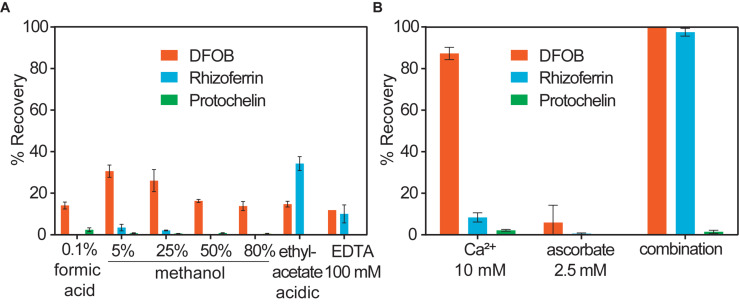
Soil siderophore spike-recovery for DFOB, rhizoferrin, and protochelin (each spiked at 6.25 nmol g–1). (A) Solvent extractions show low recoveries, particularly for rhizoferrin and protochelin. (B) A strong synergistic effect was observed for DFOB and rhizoferrin recovery when Ca2+ and ascorbate were used in combination as chemical extraction agents.